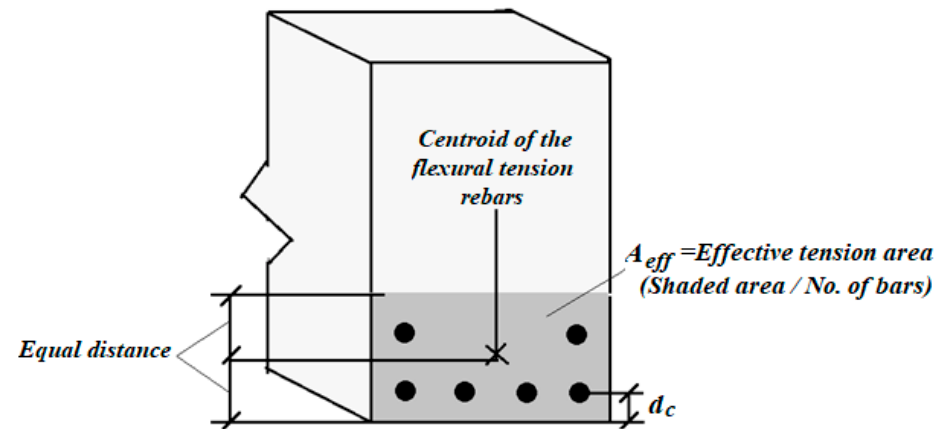
Figure 4. Determination of A , d c and S to calculate the flexural crack spacing according to ACI 224R-01 [57].